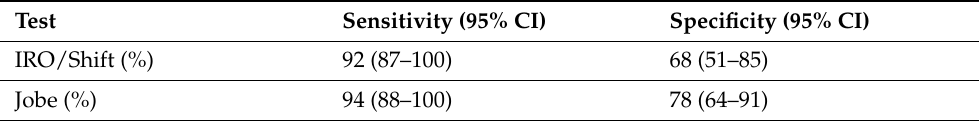
Table 1. IRO/Shift and Jobe test performance prior to shoulder surgery (confirmed with